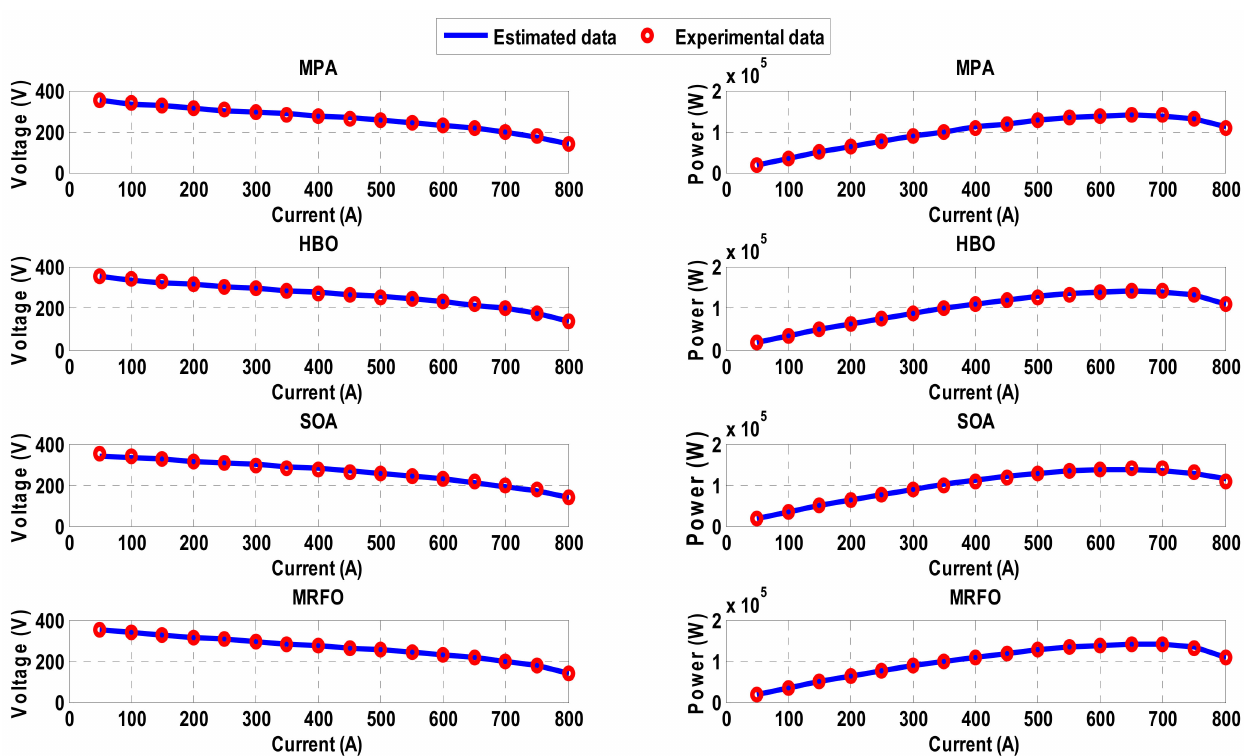
Figure 8. The measured and calculated polarization curves of SOFC dynamic-state model operated at 1273 K obtained via MPA, HBO, SOA, and MRFO.